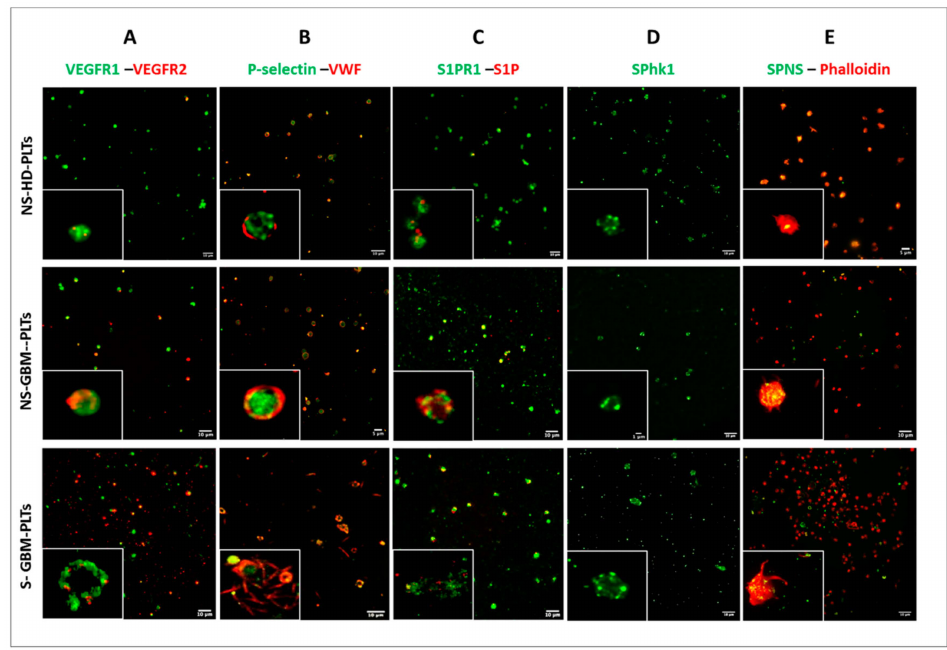
Figure 2. Localization of pro-angiogenic and pro-tumoral molecules in GBM-PLTs and HD-PLTs by immunophenotypic analysis. Representative images of immunofluorescence analyses conducted on non-stimulated (NS)-HD-PLTs, NS-GBM-PLTs, and stimulated (S)-GBM-PLTs. Immunolabeling was performed for ( A ) VEGFR1 and VEGFR2, ( B ) P-selectin and VWF, ( C ) S1PR1 and S1P, ( D ) SphK1, ( E ) SPNS and Phalloidin. The white box contains an enlargement of the image. Scale bar: 10 µ m.